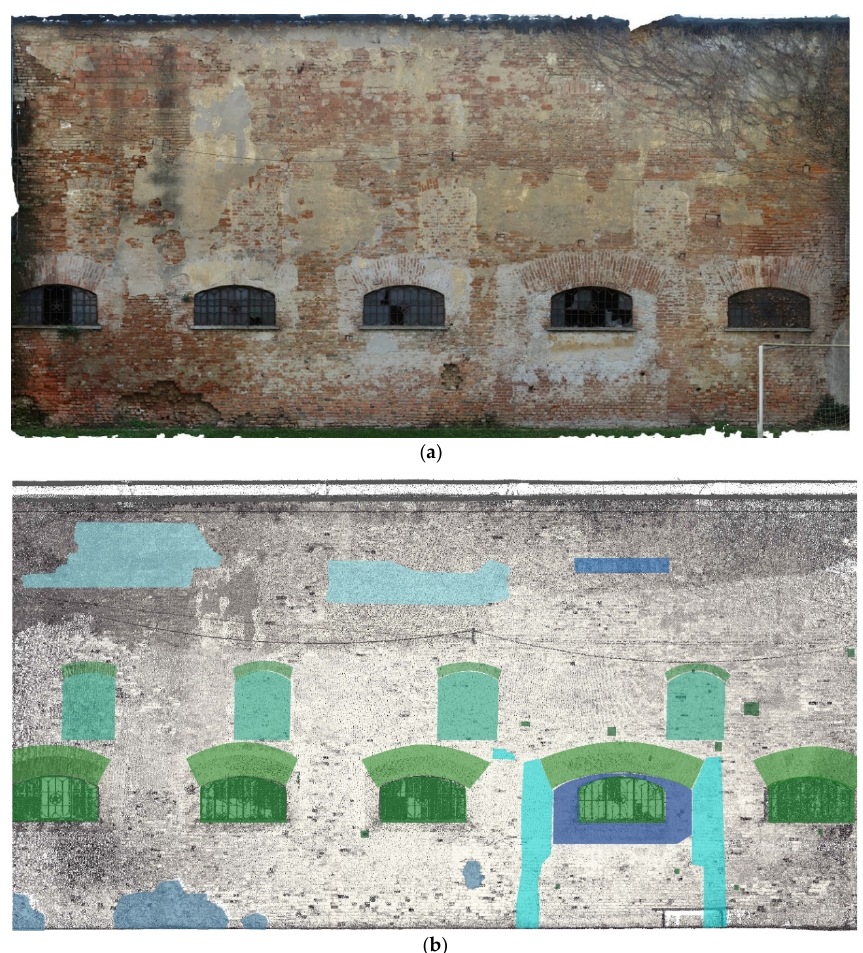
Figure 3. ( a ) A picture of an ancient masonry; ( b ) The analysis of masonry